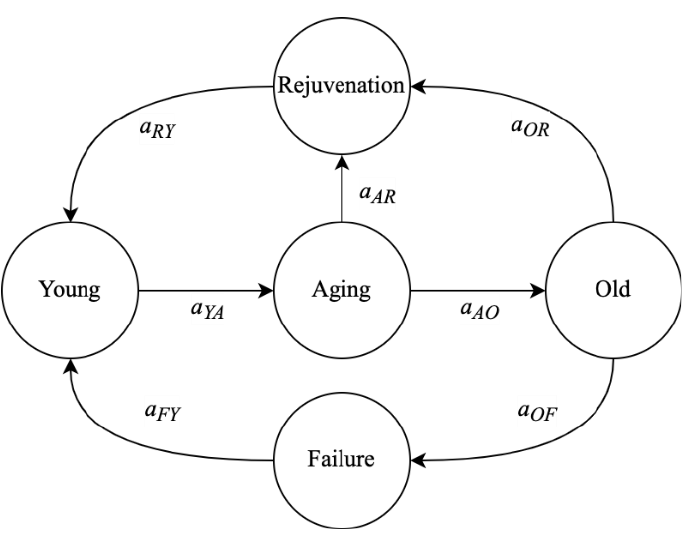
Figure 2. Graph of states and transitions of the general aging and rejuvenation model, which considers different levels of aging.